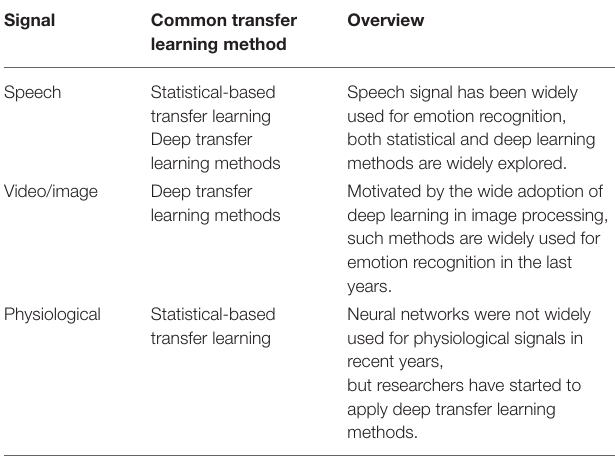
TABLE 4 | Overview of current